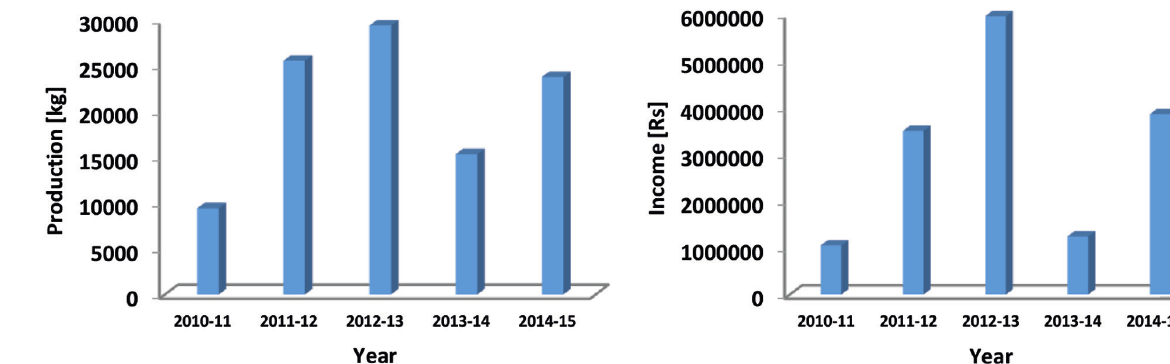
wise.Fig. 6. Year wise selling price of fish of the